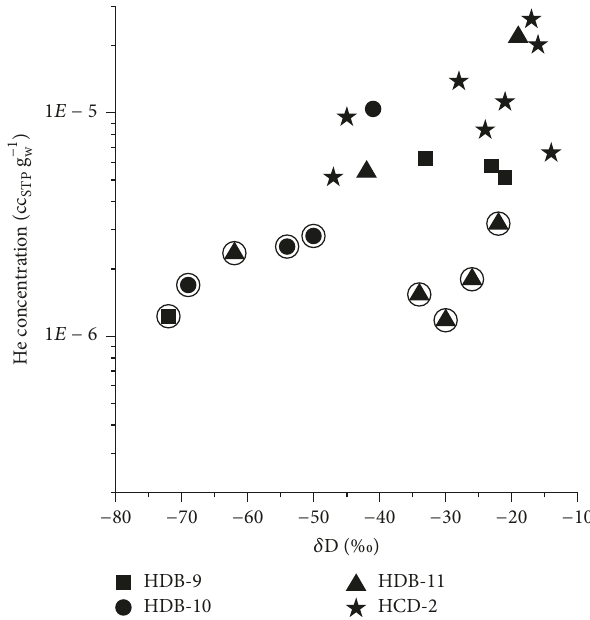
Figure 14: The relationships between 𝛿 D and He concentration in the porewater in the Koetoi and Wakkanai formations. Plots with open circle: the data plotted under or close to the dashed line in Figure